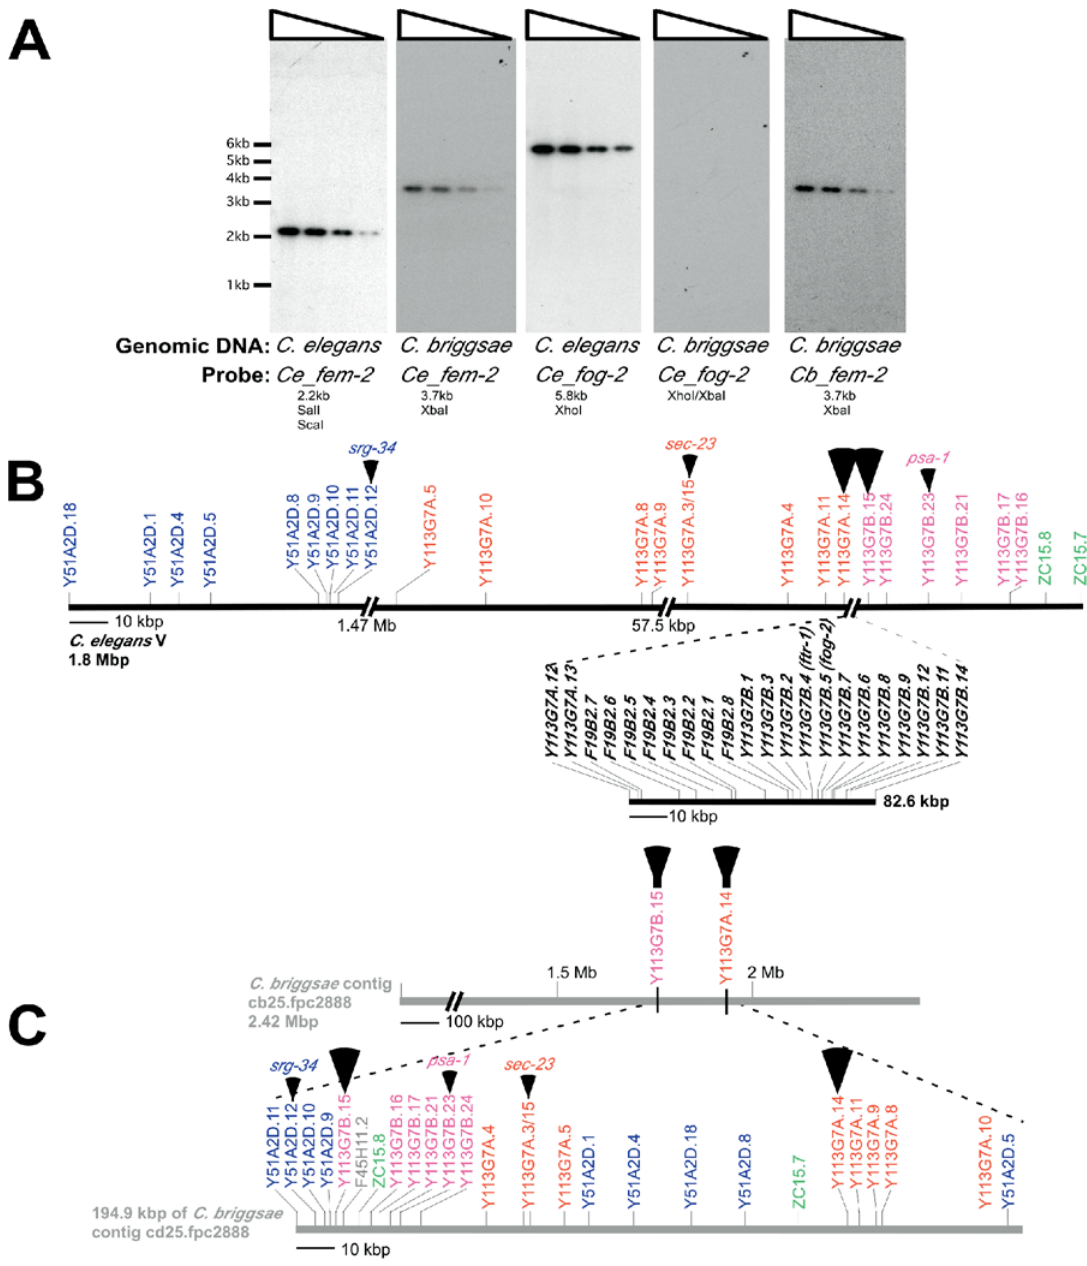
Figure 3. fog-2 Is Likely Absent in C. briggsae Low-stringency Southern blotting (A) and conservation of synteny (B and C) were used in an attempt to identify a potential fog-2 gene in C. briggsae . (A) A total of 2–20 ug of digested genomic DNA was used in low-stringency Southern blotting. C. elegans fem-2 probe ( Ce _ fem-2 ) was able to detect fem-2 on both same-species and cross-species blots (first two panels). The C. elegans fog-2 probe ( Ce_fog-2 ), which detects both fog-2 and ftr-1 on the 5.8-kb XhoI fragment, produced a signal with C. elegans but not C. briggsae genomic DNA (next two panels). fog-2 cross-species blot integrity was verified by stripping and reprobing with same-species C. briggsae fem-2 (final panel). Same-species exposures were 4 h and cross-species were 4 d. The C. elegans fem-2 probe is 70% identical to the C. briggsae genomic sequence. (B) Scale diagram of the C. elegans Chromosome 5 region containing fog-2 . A 82.6-kb enlargement below, indicated by the dashed lines, shows the fog-2 cluster containing five canonical FTR genes, one FTR gene with divergent structure, and 16 non-FTR genes (also see Table S1). (C) C. briggsae contig from the genome assembly containing flanking regions with conserved synteny. A 194.4-kb enlargement below, indicated by the dashed lines, covers the C. briggsae region that is predicted to contain a putative fog-2 ortholog. The conserved genes used to identify the C. briggsae contig are indicated by the arrowheads, with the genes flanking fog-2 indicated by the large arrowheads. Each gene from the C. briggsae contig with an ortholog defined as a reciprocal best BLAST hit is present on both maps (B and C), and blocks of synteny defined by the C. elegans organization are in the same color. Only one (Y113G7B.11) of the 22 genes from the 82.6-kb fog-2 cluster was found to have a reciprocal best BLAST hit in C. briggsae (contig cb25.fpc0129, corresponding to the predicted gene CBG05618; Table S1). No FTR genes or genes related to those in the fog-2 cluster were found within 50-kb on either side of CBG05618, indicating that this region does not share conserved synteny with the fog-2 cluster. Instead, the potential C. briggsae ortholog of Y113G7B.11 is located on a C. briggsae contig region that shows extensive conserved synteny with a different portion of C. elegans Chromosome 5 not involving the fog-2 cluster (Table S2). DOI: 10.1371/journal.pbio.0030006.g003 PLoS Biology |